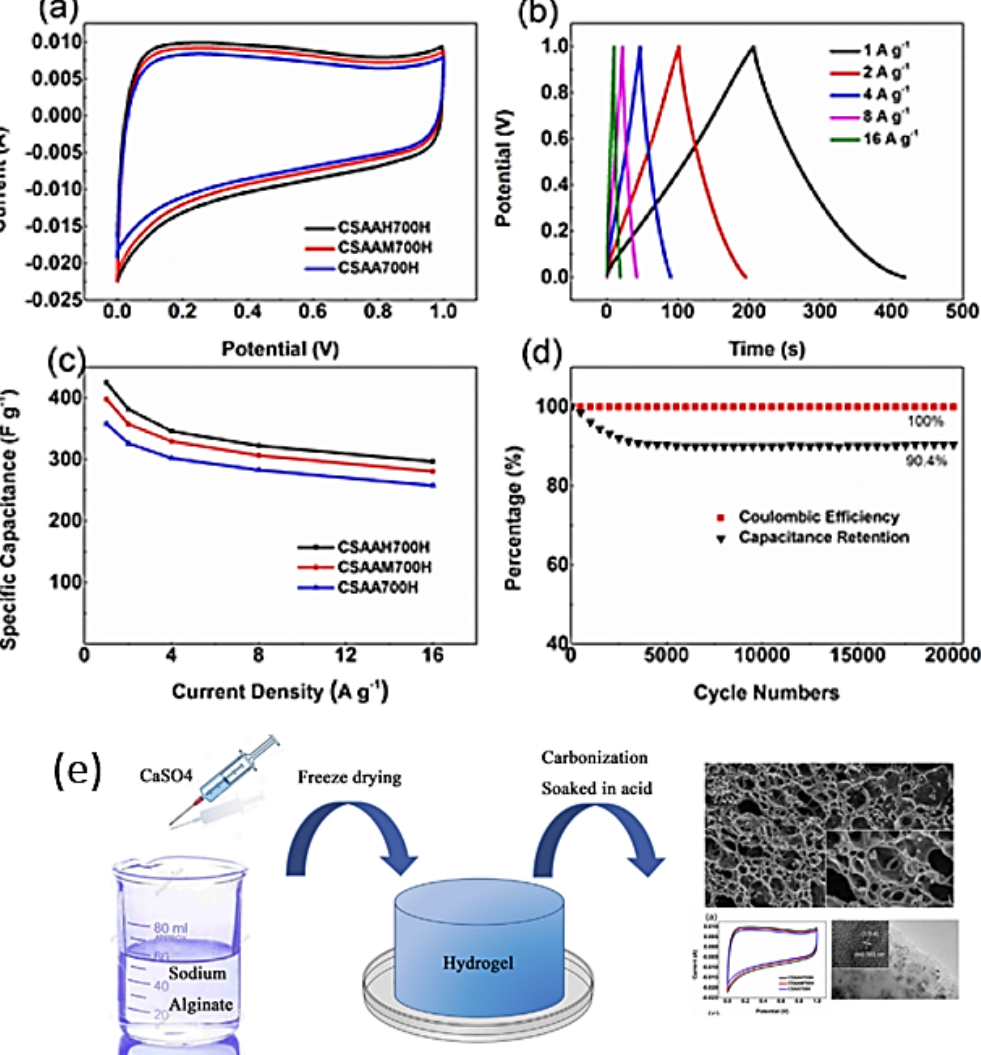
Figure 9. ( a ) CV curves of various synthesized sodium alginate compositions at the scanning rate of 0.01 V/s, ( b ) GCD curves of sodium alginate at different current densities, ( c ) the specific capacitance of various synthesized sodium alginate samples, ( d ) coulombic efficiency and cycle stability at 8 A/g current density, ( e ) synthesis method for sodium alginate. Adapted from reference [67]. This article is an open-access article distributed under the terms and conditions of the Creative Commons Attribution (CC BY-NC-ND 4.0) license.